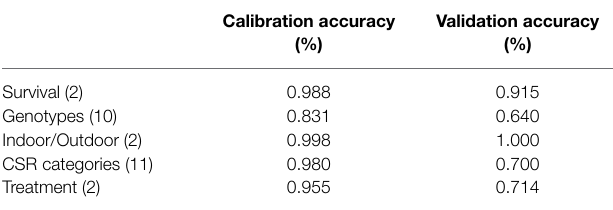
TABLE 2 | Prediction accuracy for five plant categories.